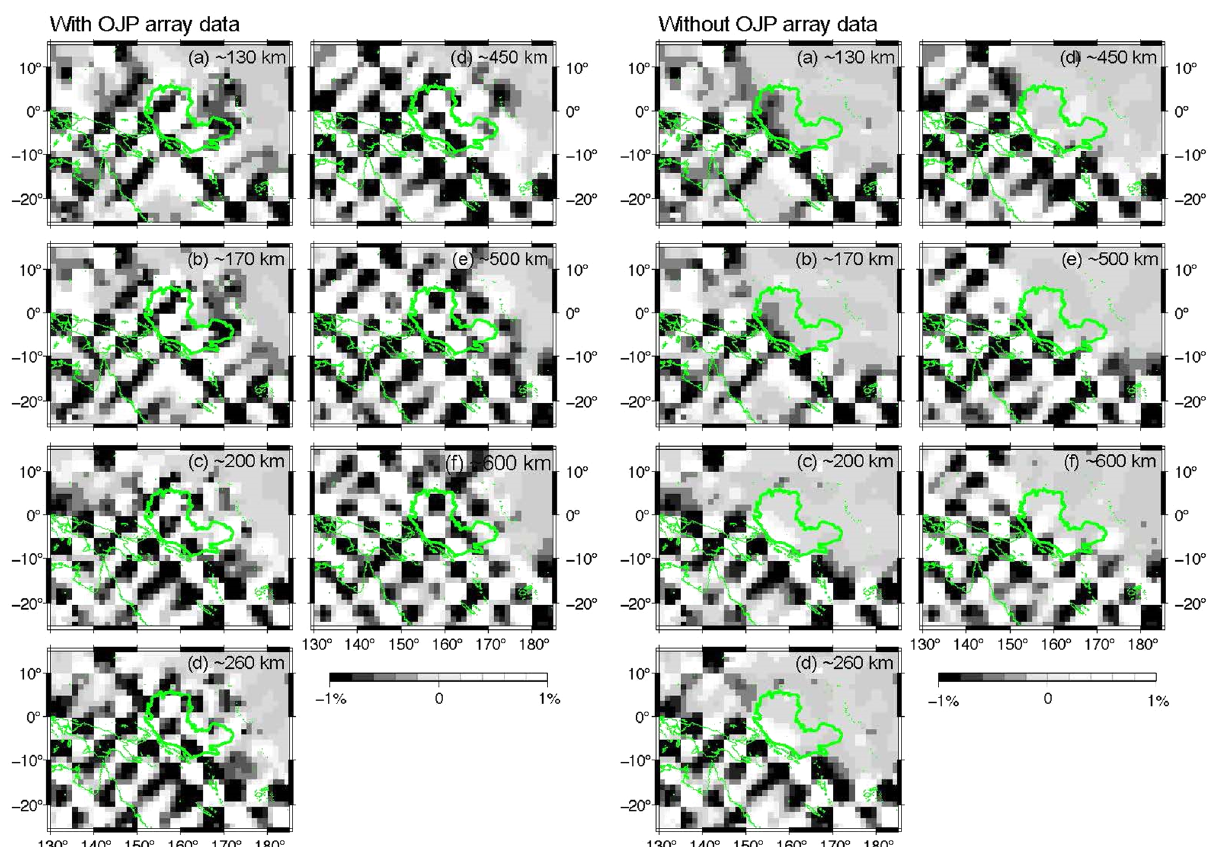
Figure 6. Results of the checkerboard resolution test for the 5° × 5° size pattern in latitude and longitude. (Left) Results based on all the data in this study, (right) results based on all the data excluding data from the OJP array and PP–P differential time data wherein the PP-waves bounce around the OJP. The GMT 5.4.5 53 was used to make this